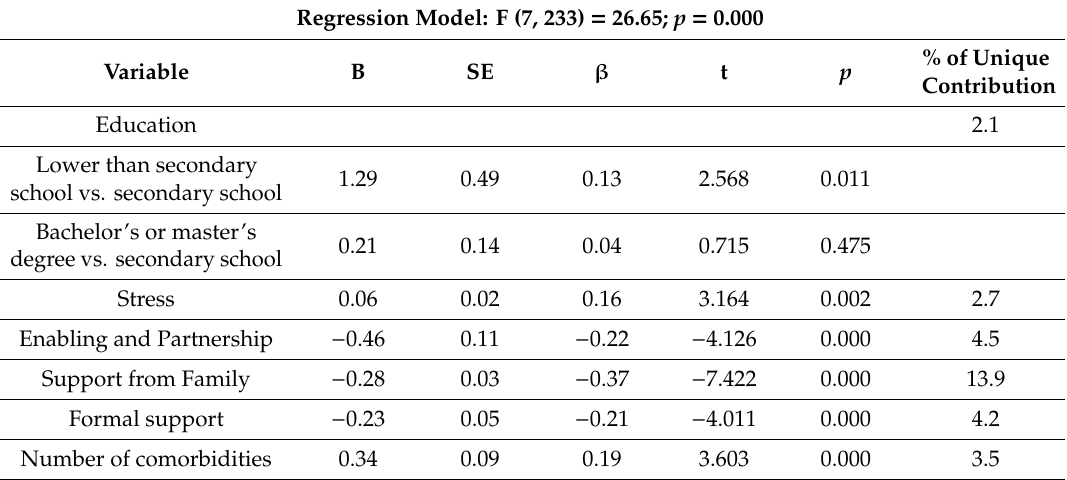
Table 12. Multiple regression model, explaining family needs for support.